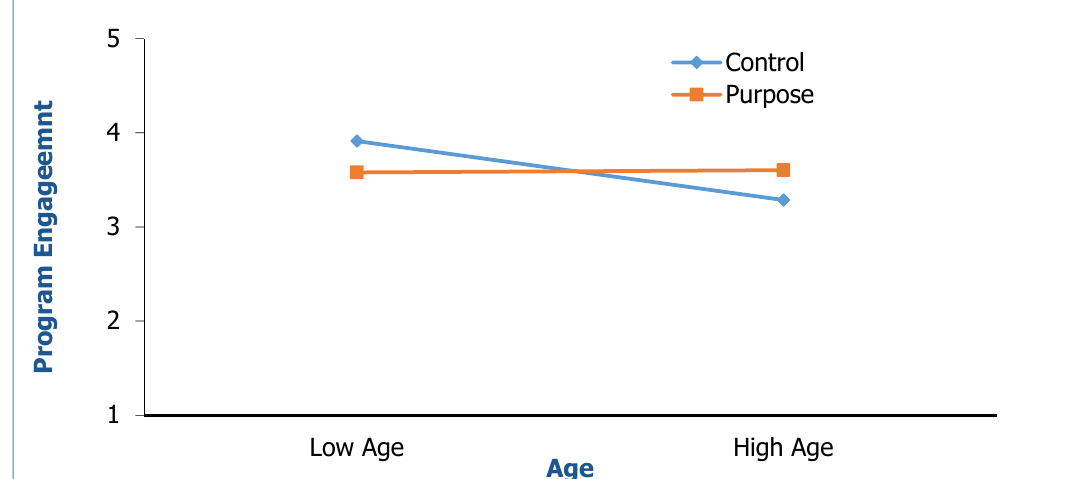
Figure 1. Interaction Between Age and Writing Condition Predicting Program